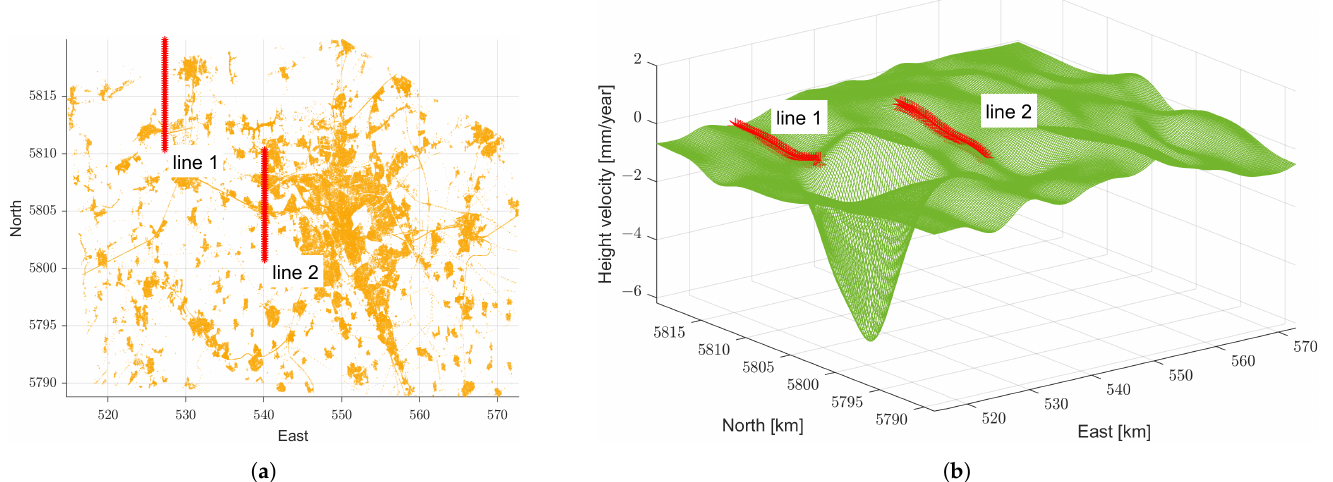
Figure 12. The two selected lines to observe the CI. ( a ) Observations (2D view). ( b ) Approximated surface (Figure 8) (3D view).